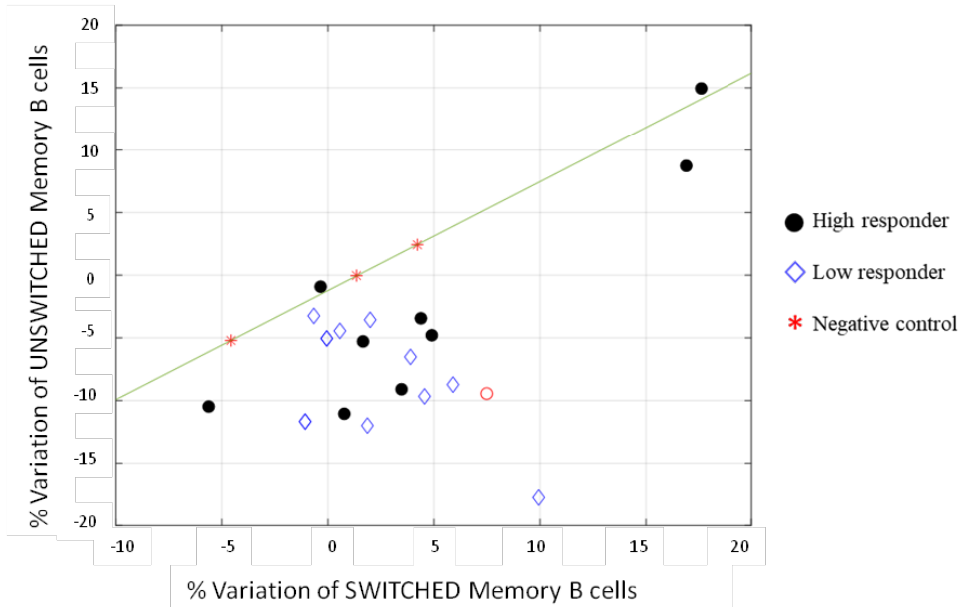
Figure 4. Representation of the relative variation of switched and unswitched memory B-cell populations normalized to the overall amount of B-cells. The mathematical expression y = 0.8694 * x − 1.2207 indicates that any point laying below y is, with high probability, a high or low responder. Finally, we found an interesting correlation between Th17 cells and neutralizing an- tibodies to SARS-CoV-2. Figure 5 show that all samples had a positive percentage of Th17 variation corresponded to subjects having neutralizing antibodies; only five low re- sponders (NT antibody titer <20 after one month) and a high responder (red circle in Figure 5) did not present a positive variation of Th17 after six months. A cut-off could be set with an NT value of 19.5.